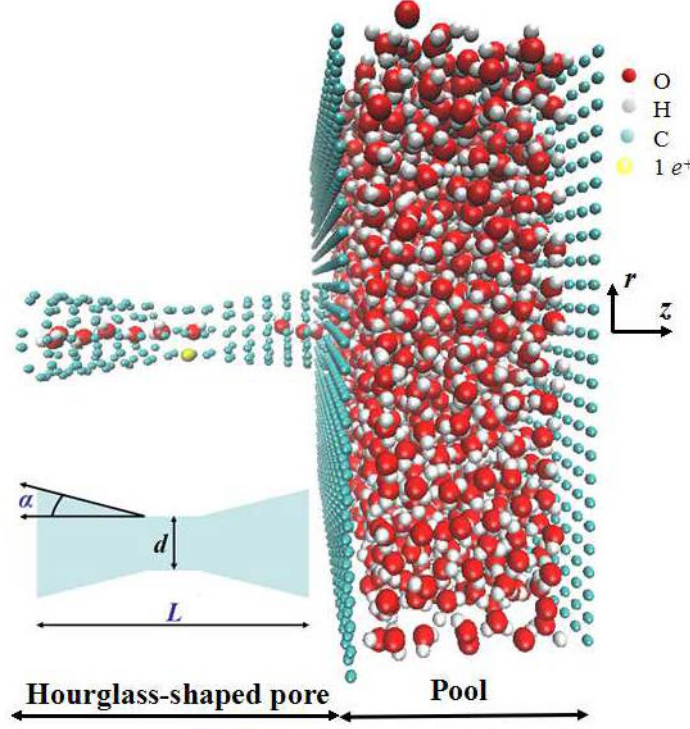
Figure 1. Schematic representation of the molecular dynamics simulation model. The narrowest center diameter d is fixed at 3 Å. We varied the total length of the hourglass-shaped pore L and the cone angle α .